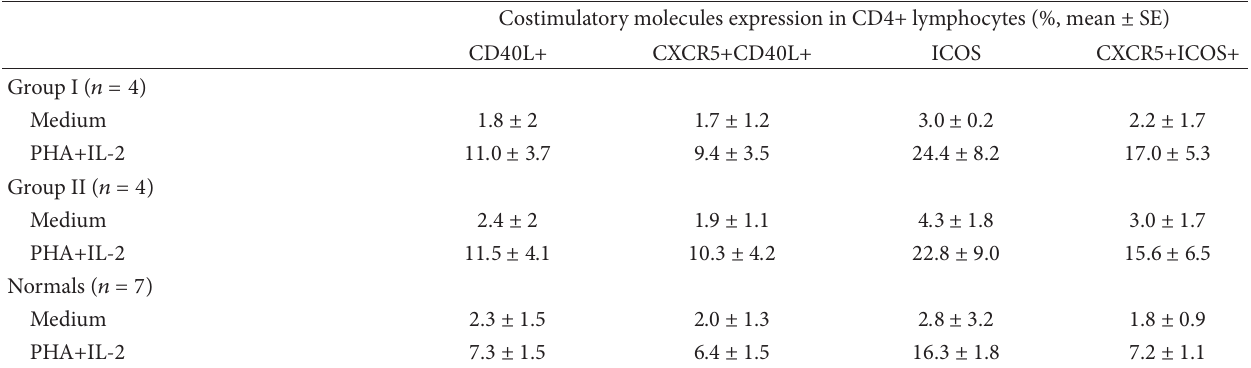
Table 2: Expression of costimulatory molecules (CD40L and ICOS) in PHA+IL-2 stimulated PBMC from CVID patients and